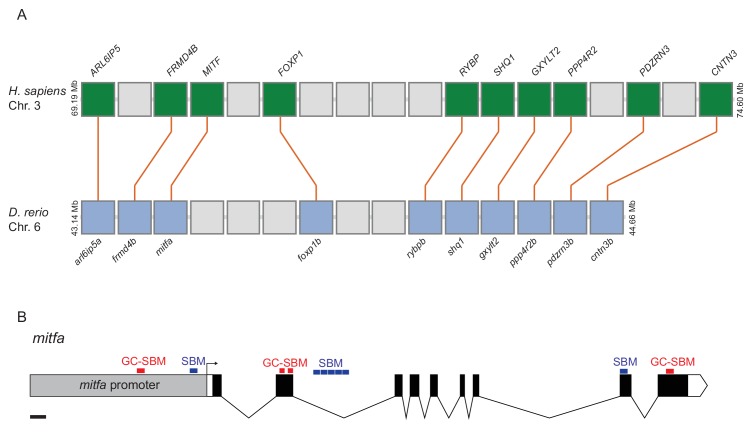
Diagram of synteny between MITF and mitfa loci and SMAD binding motifs at the mitfa locus.(A) Diagram of orthologous genes flanking the MITF and mitfa loci in human and zebrafish genomes, respectively. H. sapiens, Homo sapiens; D. rerio, Danio rerio. (B) Diagram of mitfa locus, including promoter, intronic and exonic regions with identified SMAD binding motifs (SBM) and GC-rich SMAD binding motifs (GC-SBM). Scale bar = 200 bp.